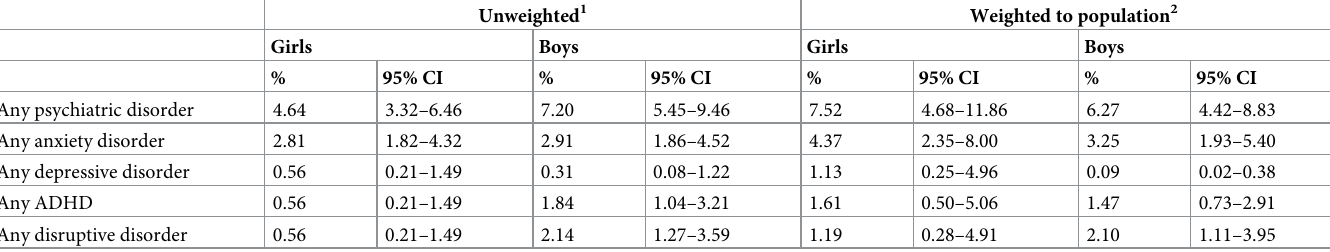
Table 3. Prevalence of DSM-IV disorders among 10-14-year-old participants in the Bergen Child Study, by